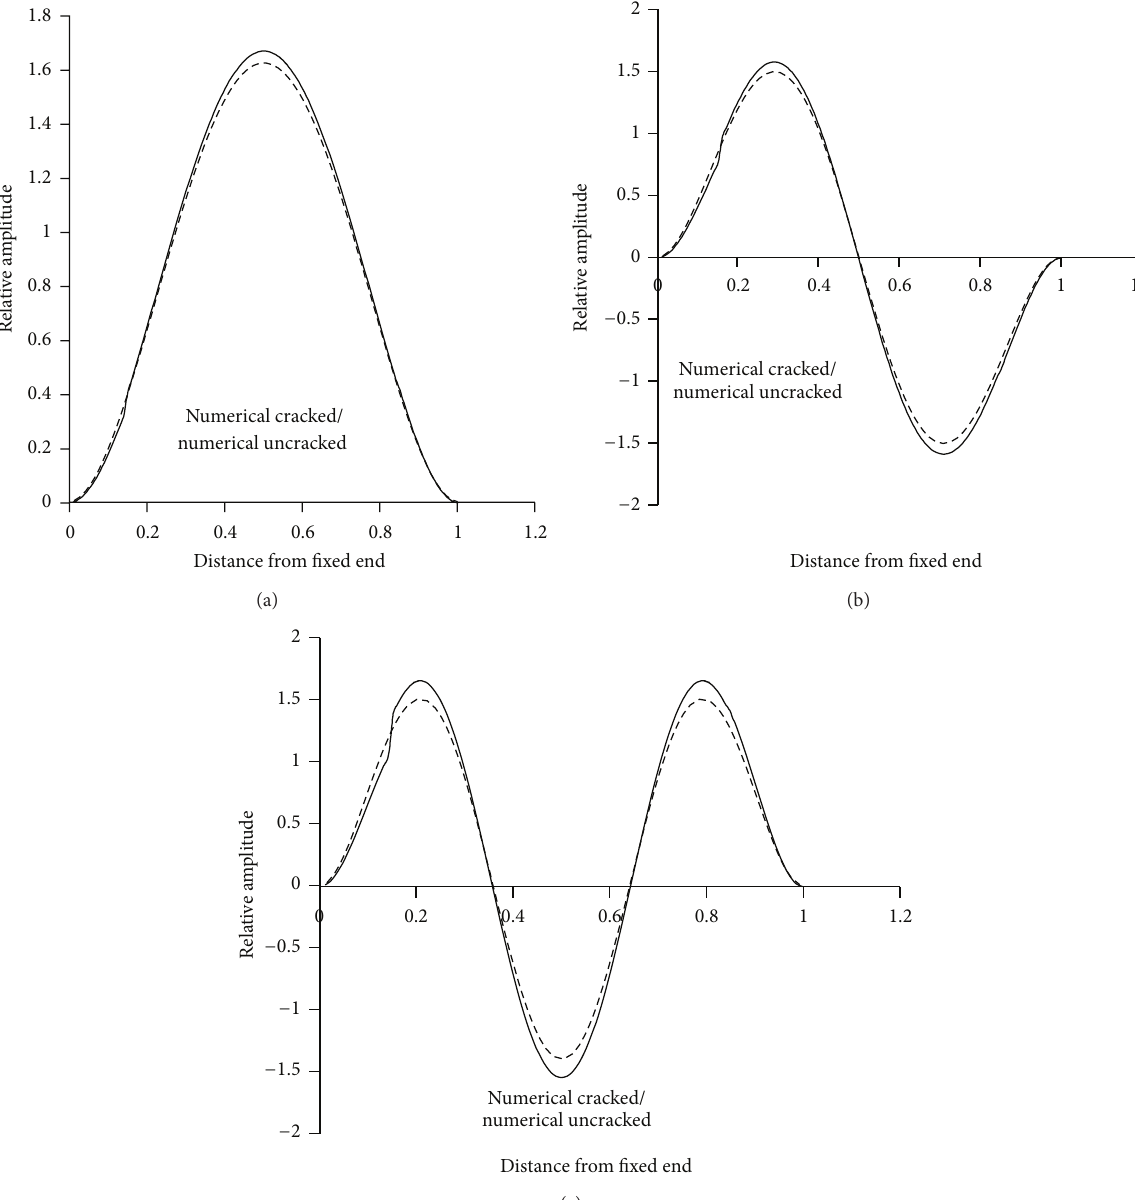
Figure 4: (a) Relative amplitude versus distance from the fixed end (1st mode of vibration) 𝐿 1 = 0.015 m, 𝐿 2 = 0.85 m, 𝑏 1 /𝐷 = 0.1 , and 𝑏 2 /𝐷 = 0.1 . (b) Relative amplitude versus distance from the fixed end (2nd mode of vibration) 𝐿 1 = 0.015 m, L 2 = 0.85 m, 𝑏 1 /𝐻 = 0.1 , and 𝑏 2 /𝐻 = 0.1 . (c) Relative amplitude versus distance from the fixed end (3rd mode of vibration) 𝐿 1 = 0.015 m, 𝐿 2 = 0.85 m, 𝑏 1 /𝐷 = 0.1 , and 𝑏 2 /𝐷 = 0.1